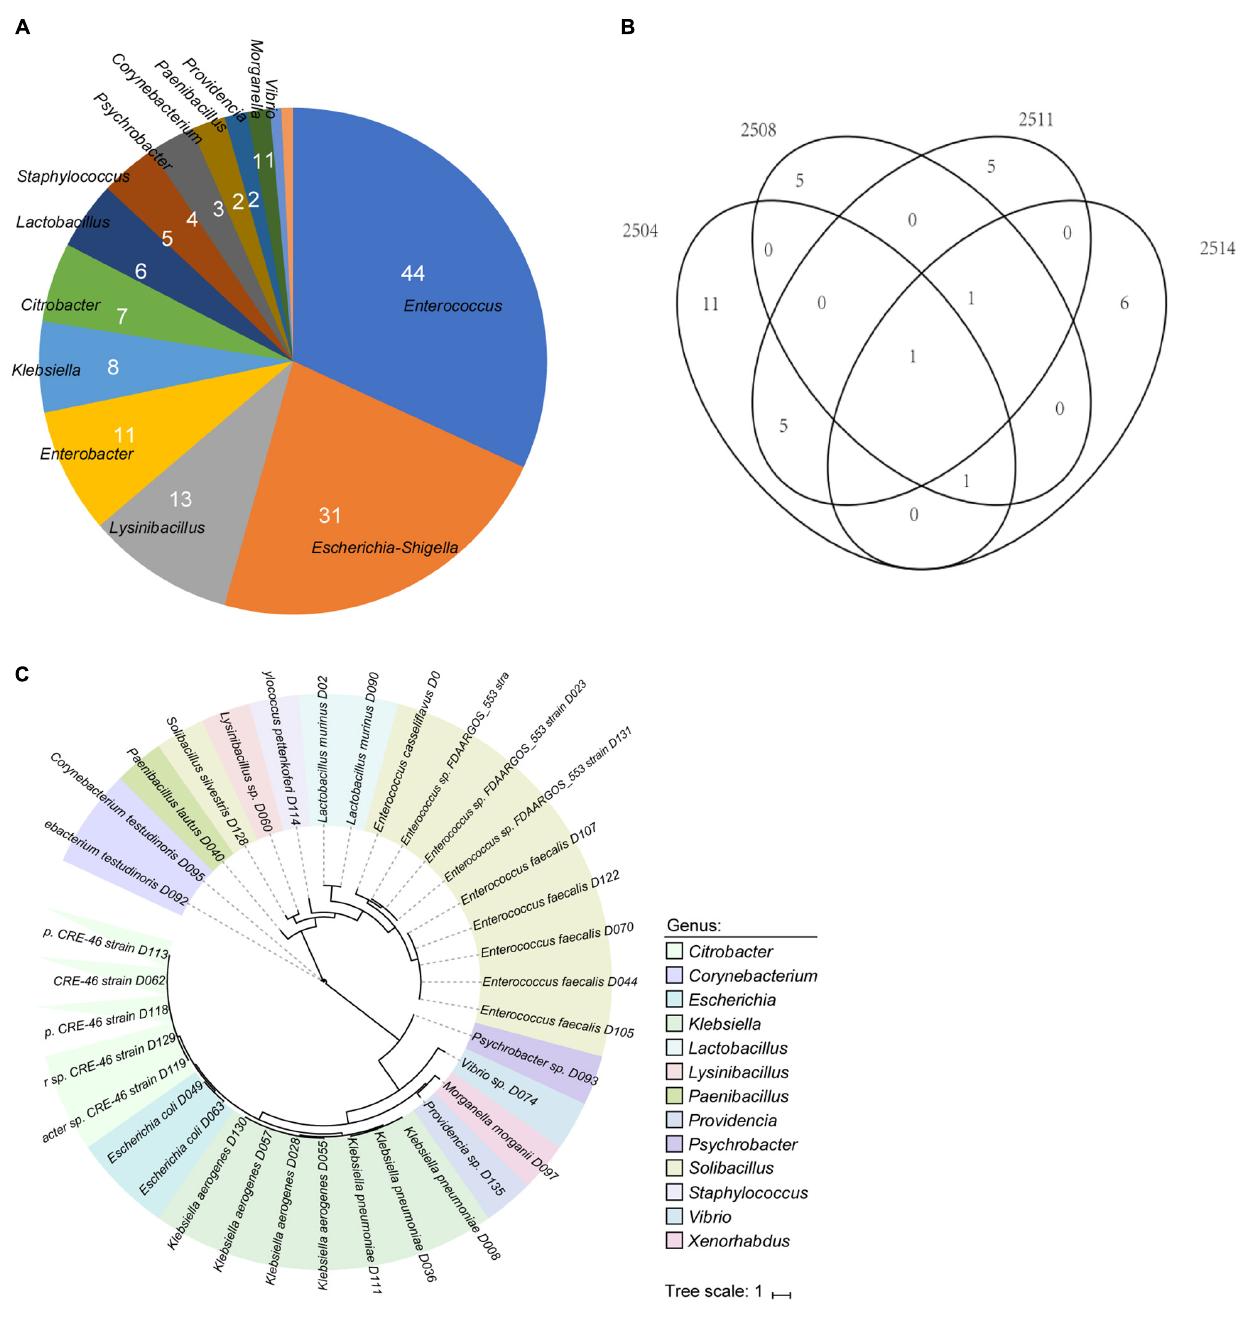
FIGURE 1 | Overview of the cultivated bacteria from bile specimens. (A) Pie plot shows the composition of 138 bacterial colonies. (B) Venn diagram of the distribution of isolates in the four bile samples. (C) Phylogenetic tree of 35 whole-genome sequenced isolates. Color represents the genus assignment of the